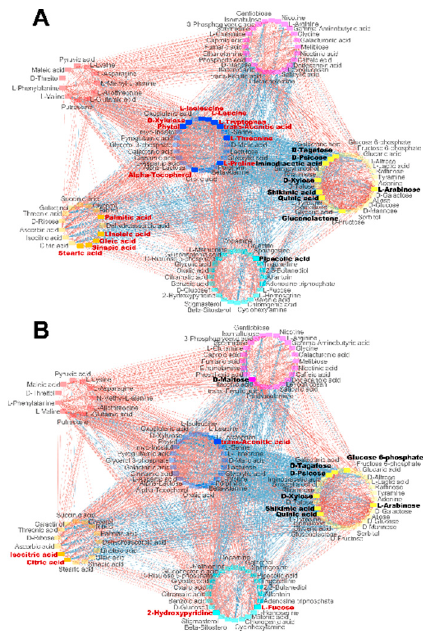
Figure 4. Network diagrams showing significant correlations ( p ≤ 0.05) between leaf metabolite accumulation at the V stage and agronomic traits based on the calculation of Pearson coefficients. ( A ) Correlations between leaf metabolites and shoot dry weight (DW). ( B ) Correlations between leaf metabolites and kernel yield (KY). The red lines and blue lines represent positive and negative correlations between groups of metabolites, respectively. The names of the metabolites positively or negatively correlated with shoot DW and KY are highlighted in black and red, respectively. The circles correspond to the six groups of metabolites obtained following hierarchical clustering of the Pearson correlations between the amount of leaf metabolites at the V stage, shoot dry weight and kernel-related traits. The list of metabolites belonging to each of the six groups are provided in Supplemental dataset 5.